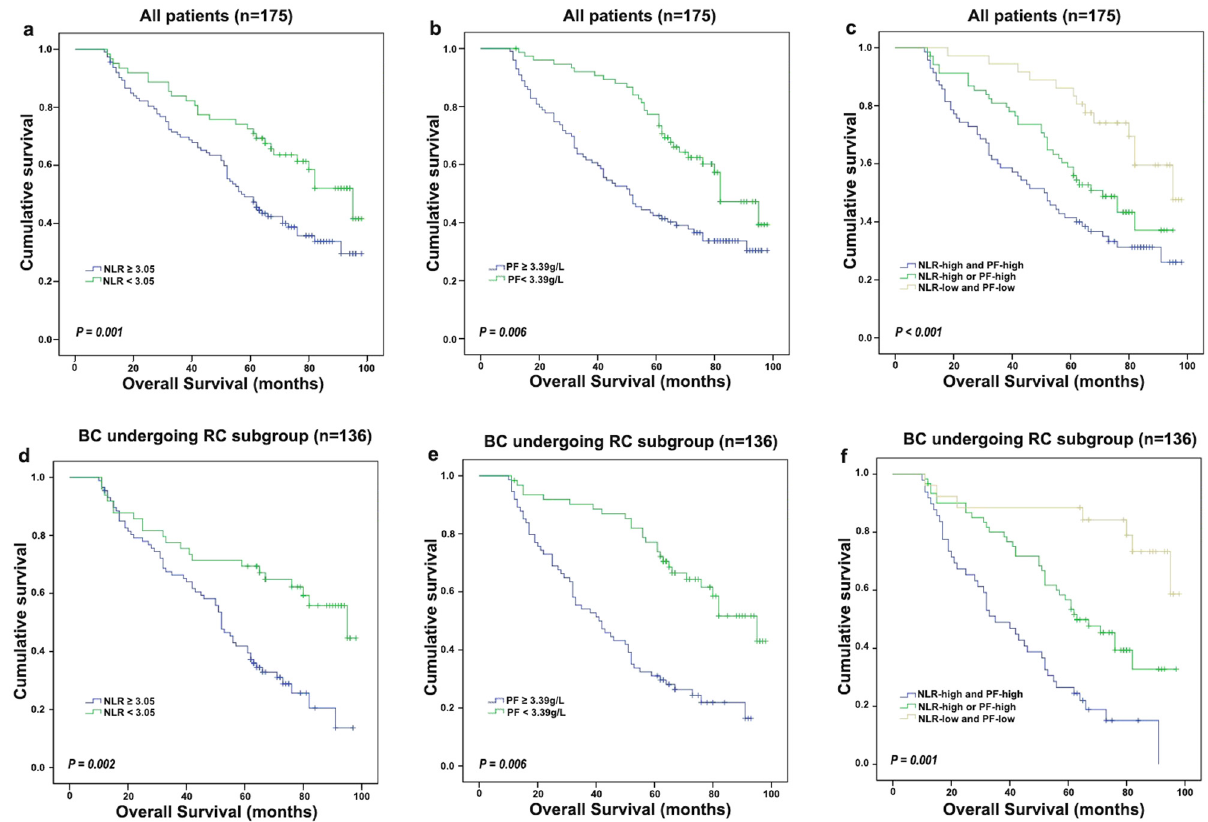
Figure 1: Prognosis signi fi cance of NLR and PF in all BC and BC following RC subgroup patients. The 5 - year OS rate was calculated by the Kaplan – Meier method and analysed by the log - rank test. ( a and d ) OS based on NLR in all patients and RC subgroup. ( b and e ) OS based on PF in all patients and RC subgroup. ( c and f ) OS of combined NLR - and PF - based categorization in all patients and RC